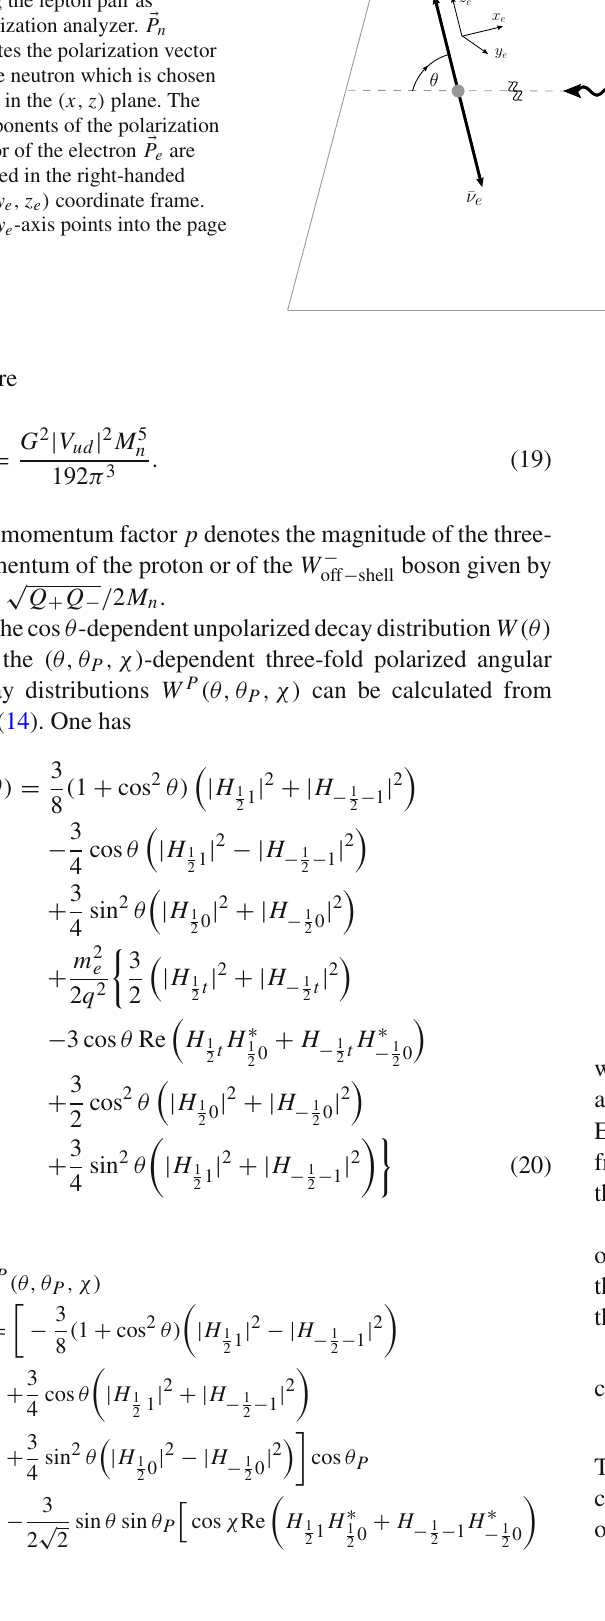
Fig. 1 Definition of the polar angles θ and θ P , and the azimuthal angle χ describing the decay of a polarized neutron using the lepton pair as polarization analyzer. (cid:6) P n denotes the polarization vector of the neutron which is chosen to lie in the ( x , z ) plane. The components of the polarization vector of the electron (cid:6) P e are defined in the right-handed ( x , y , z ) coordinate frame. e e e The y e -axis points into the page